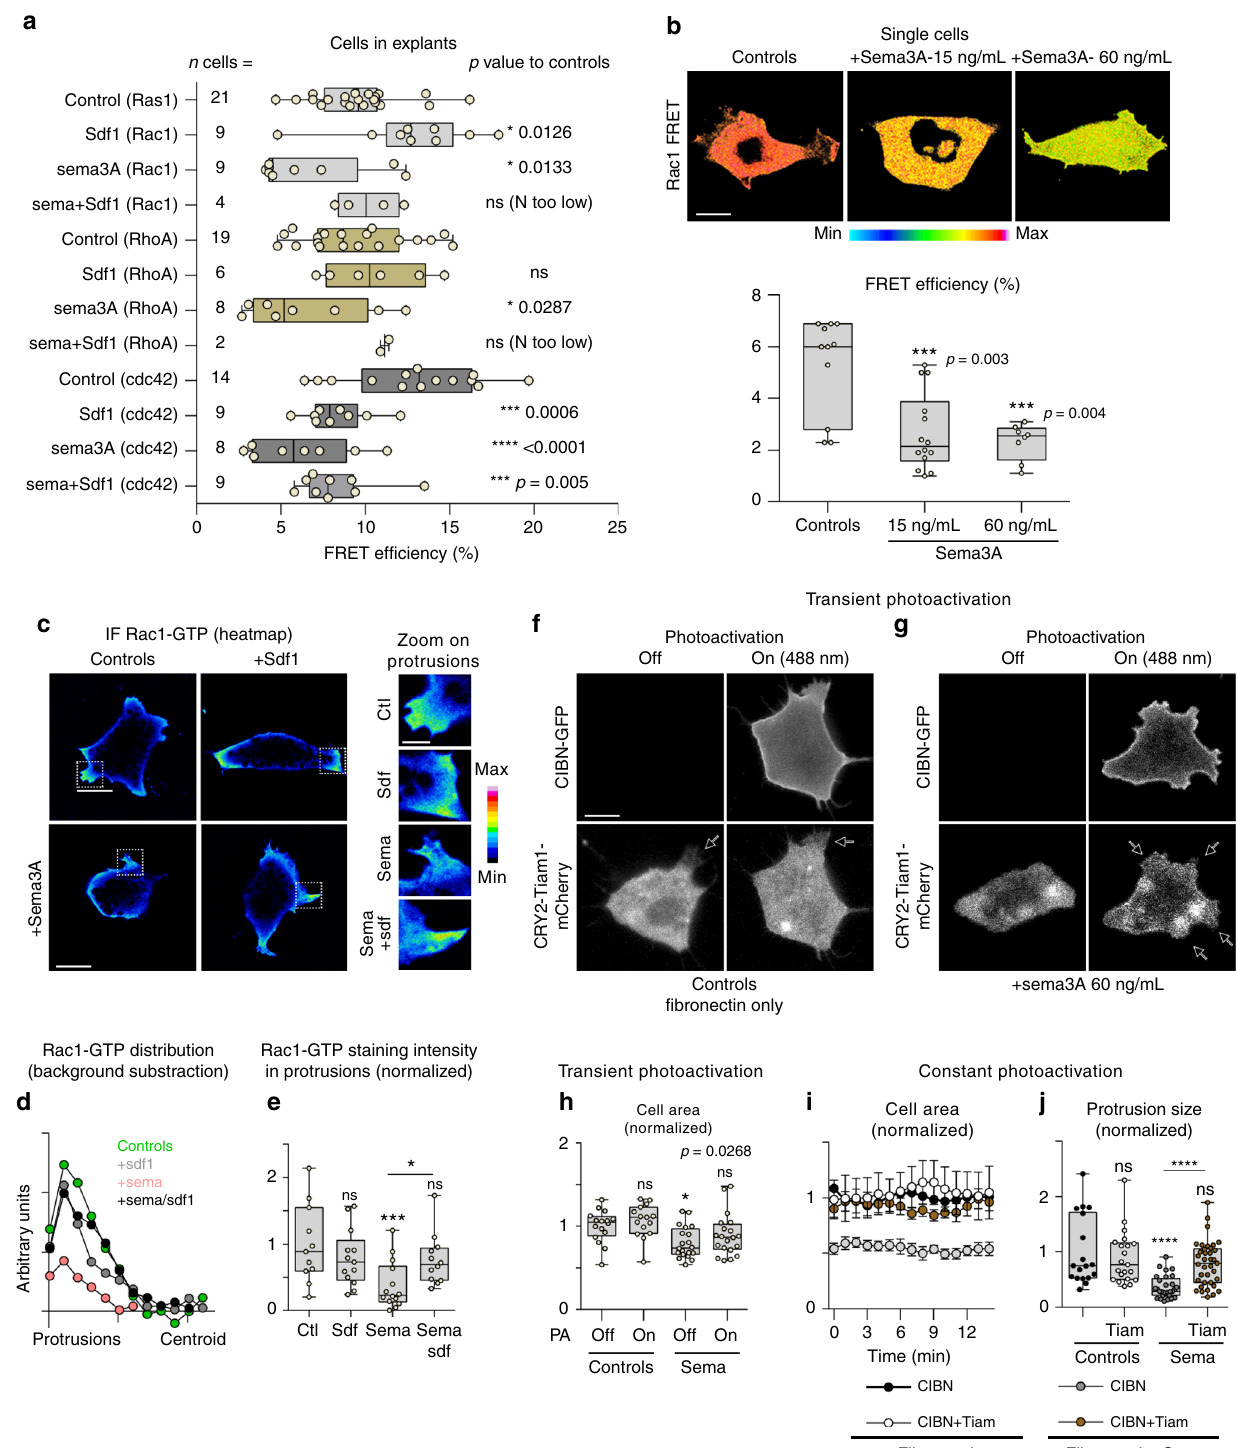
effect on Cdc42 (Fig. 6a). These data indicate that Sdf1 and Sema3A have opposite effects on Rac1 in NC cells in explants. We then performed the FRET assay on cells plated individually (Fig. 6b) to avoid feedbacks from cell – cell adhesion. We con- fi rmed that Sema3A decreased Rac1 activity. To substantiate these data, we assessed Rac1-GTP distribution by immuno fl uorescence (Fig. 6c). Sema3A reduced polarised distribution of Rac1-GTP (Fig. 6c, d) and intensity in protrusions (Fig. 6c, zooms and